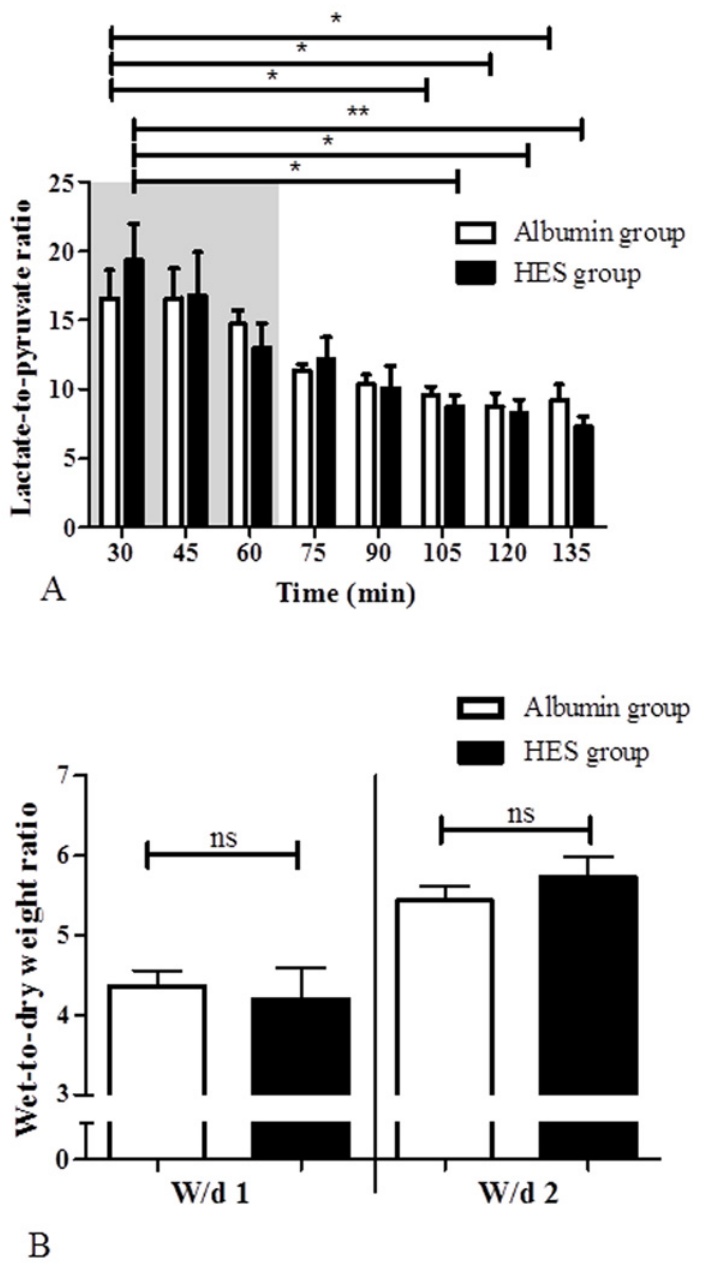
Fig 2. Lactate-to-pyruvate ratio and wet-to-dry weight ratio. A) Lactate-to-pyruvate ratio in the Albumin perfusion and HES perfusion group, B) wet-to-dry weight ratio before (W/d1) and after (W/d2) perfusion, in the Albumin perfusion and HES perfusion group. Areas shaded in grey indicate the equilibration phase. Error bars denote the mean ± SD. Albumin (N = 6), HES (N = 7). * , p < 0.05; ** , p < 0.01; ns, not significant.